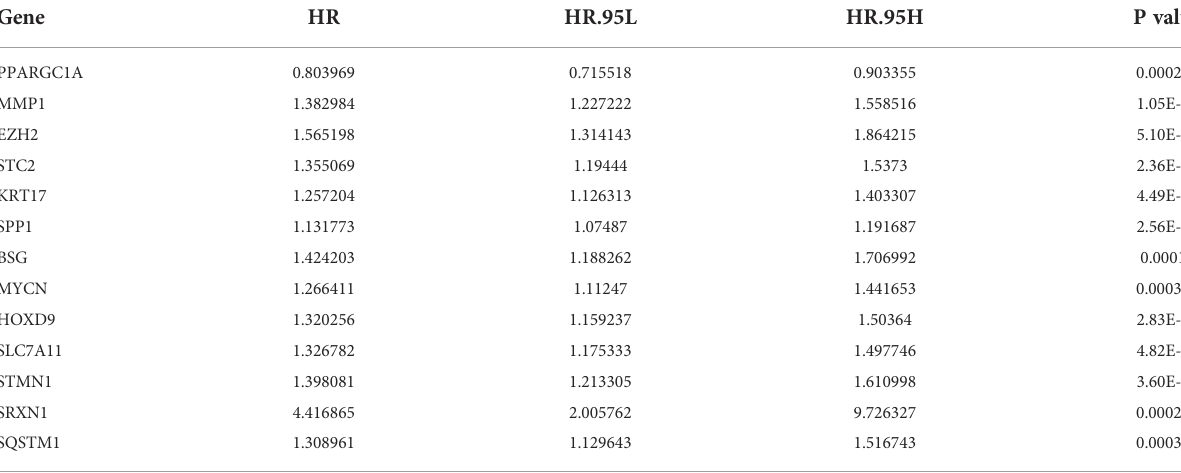
TABLE 2 The 13 genes in the LASSO